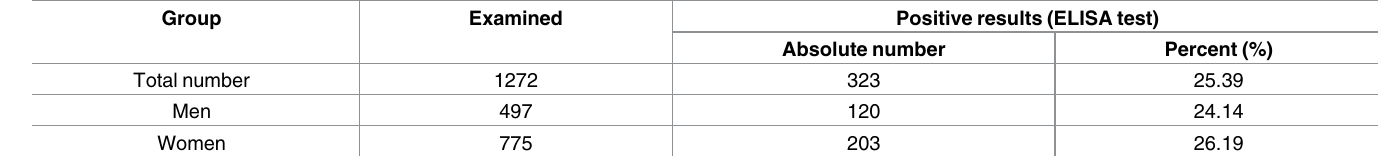
Table 1. Prevalence of chronic toxoplasmosis among the residents of Moscow city (Russian Federation), 2015. Group